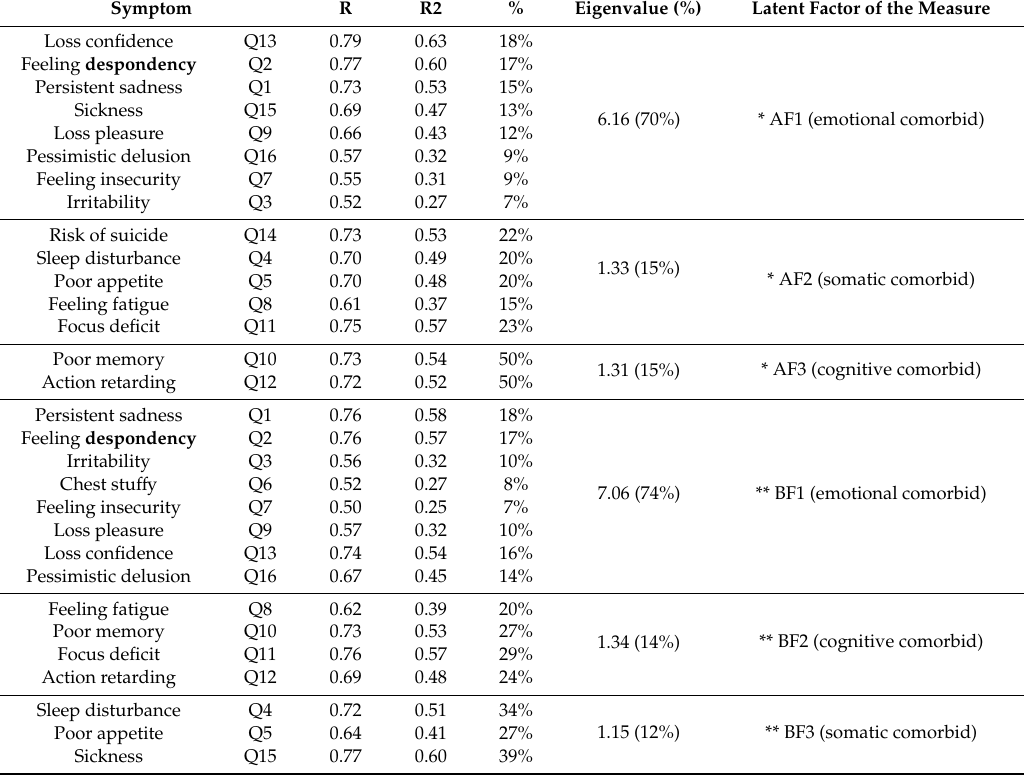
Table 2. The latent factors described the adolescent depressive prodrome via the related symptoms defined in BSM-5. The eigenvalue described the explanatory amount of variance of the integrated e ff ect of the symptoms.